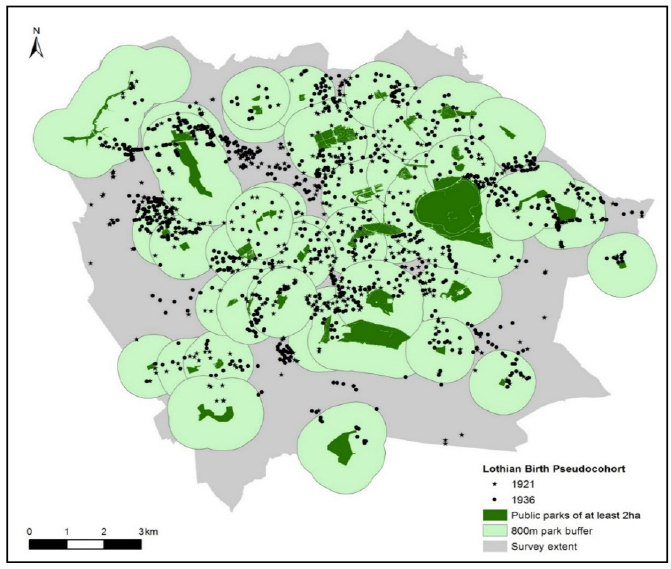
Figure 2. Distribution of the pseudo cohort in relation to public parks in the Edinburgh region in 1949.